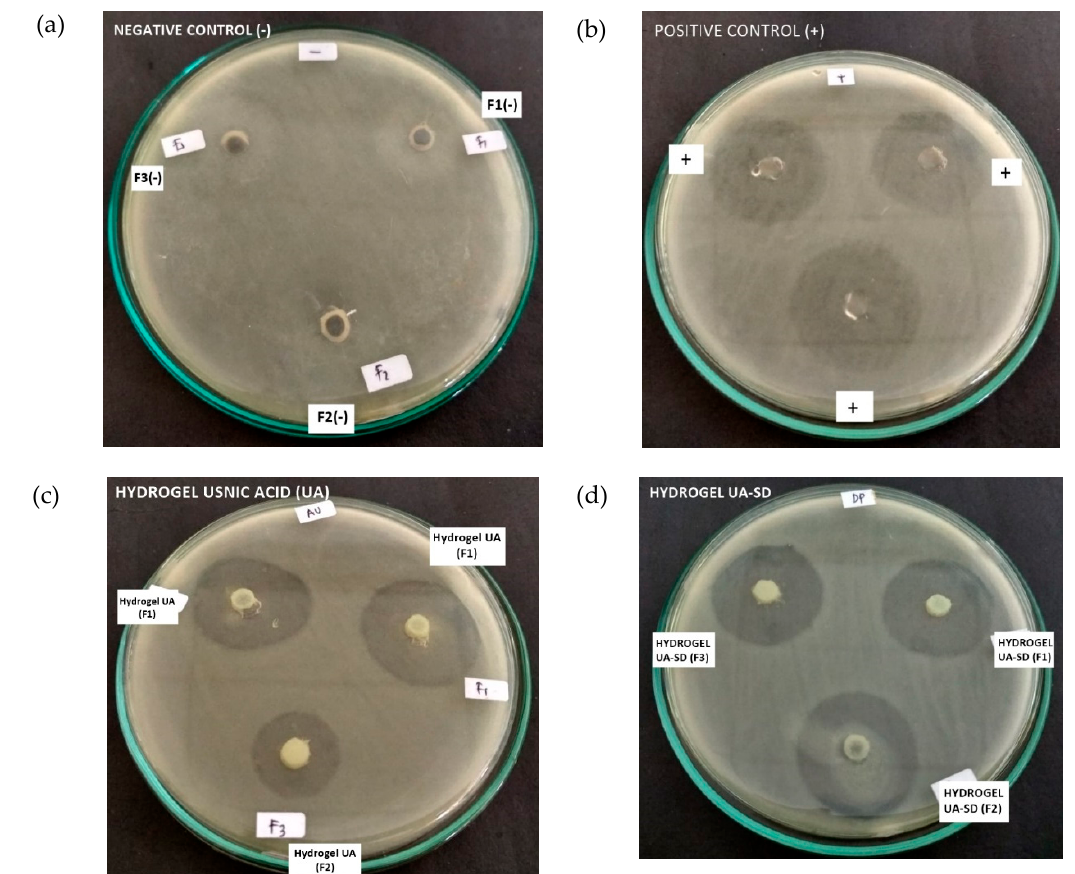
Figure 2. Result of antibacterial test against Propionibacterium acne.